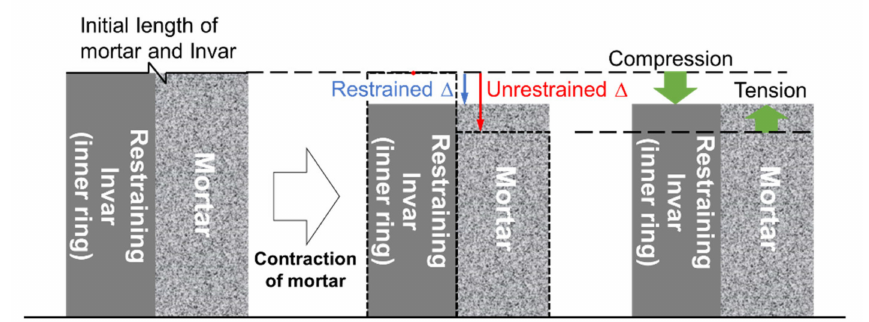
Figure 7. Conceptual schematic of operating principle of restrained ring